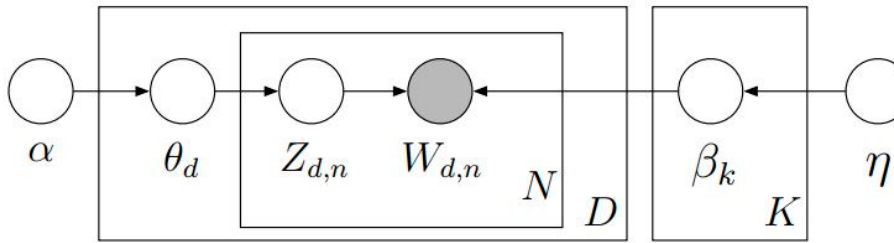
Figure 1. LDA Probabilistic Graph Model.